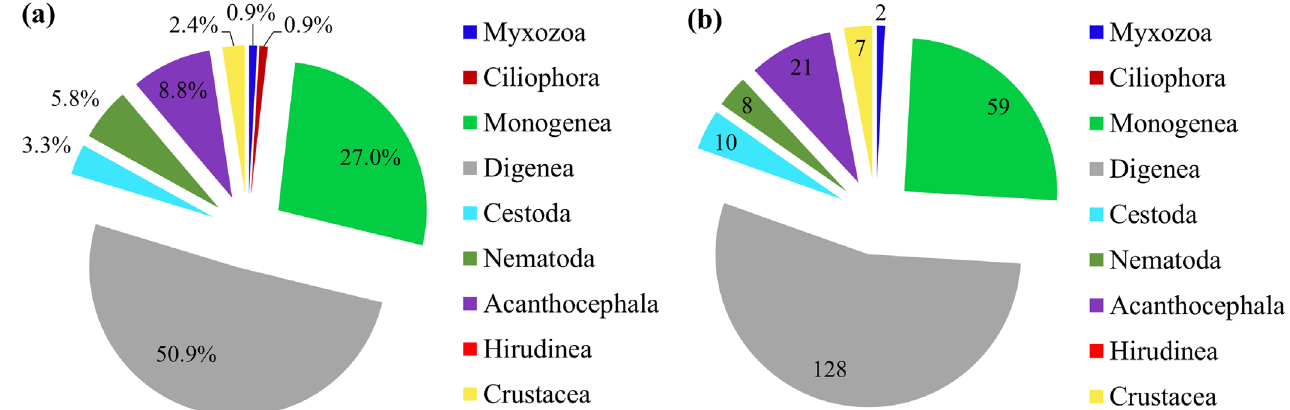
Figure 3. Marine fi sh parasites in the Gulf of Tonkin: (a) Proportion of the total recorded fi sh parasite species (%), and (b) Composition (species richness) of parasite species only found in the Gulf of